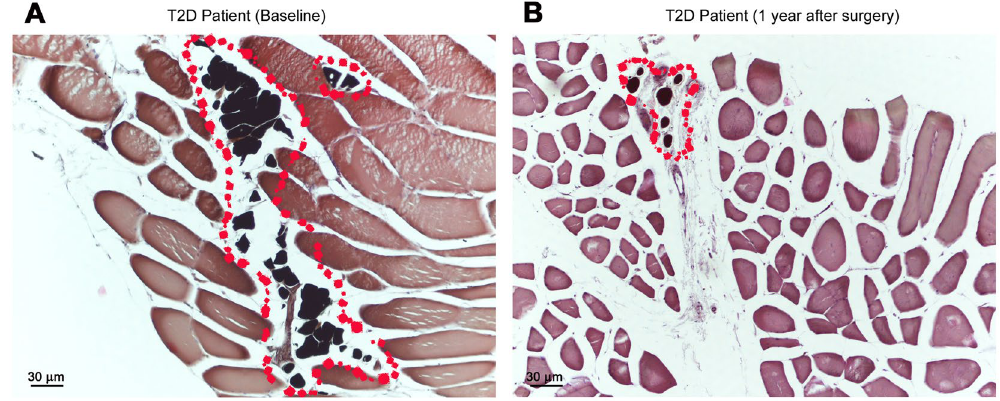
Figure 1. Skeletal muscle from a diabetic (T2D) patient pre ( A ) and post ( B ) bariatric surgery. A reduction of intermyocellular fat is evident (red dots).